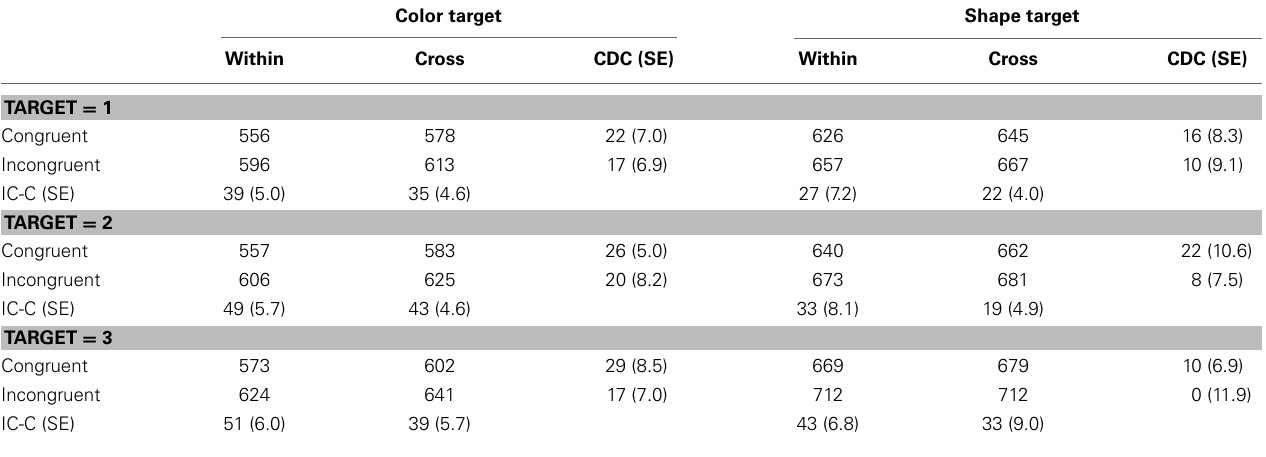
Table 4 | RTs (in milliseconds) and standard errors (SEs, in parentheses) in Experiment